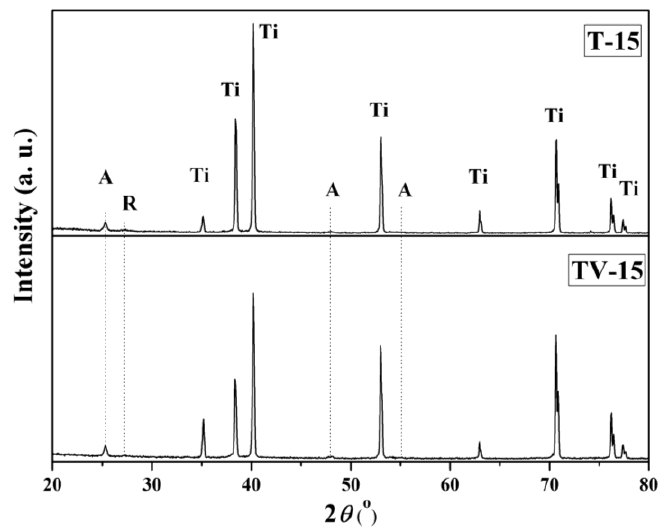
Figure 4. Diffractograms of TiO 2 nanotubes synthesized at 15 V, with and without vanadium oxide deposition.